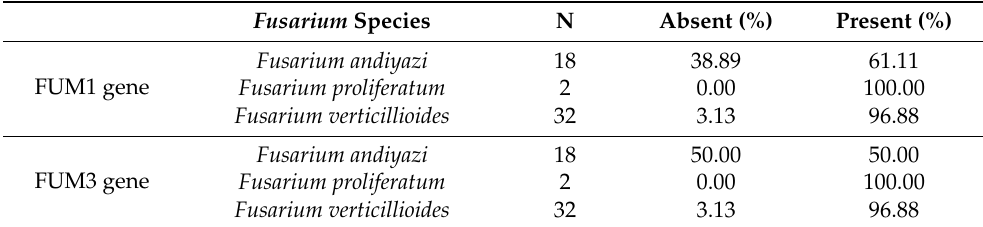
Table 4. Occurrence of fumonisin gene cluster (FUM1 and FUM3) among three species of Fusarium